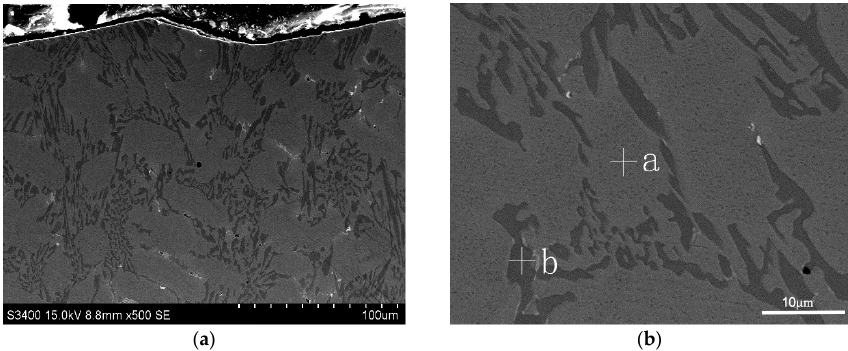
Figure 4. Morphology of the deposited Co ‐ Cr alloy coating on the bushing surface: ( a ) cross ‐ section of the Co ‐ Cr alloy coating; ( b ) position of EDS.